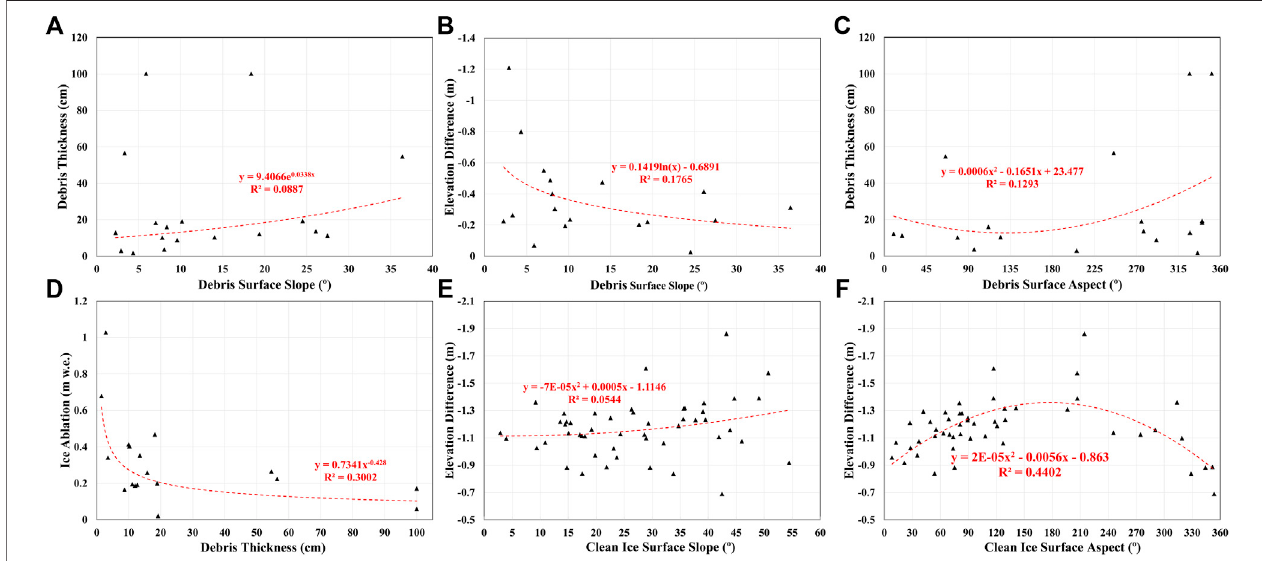
FIGURE7| Relationshipsofsurfaceslope,aspects,debristhickness,andelevationdifferences/iceablationsonmeasuredsitescomparedto50randomlyselected sites on clean ice.